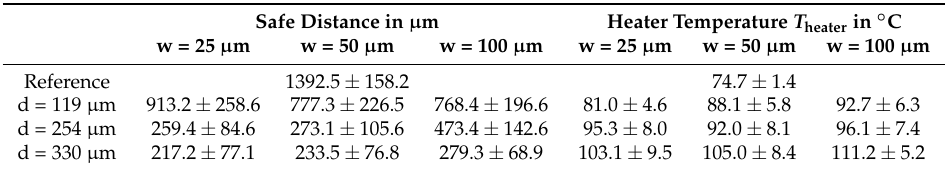
Table 1. Calculated safe distances and heater temperatures obtained for trenched demonstrators with different trench widths (w) and depths (d) for constant heating power P heat = 5.74